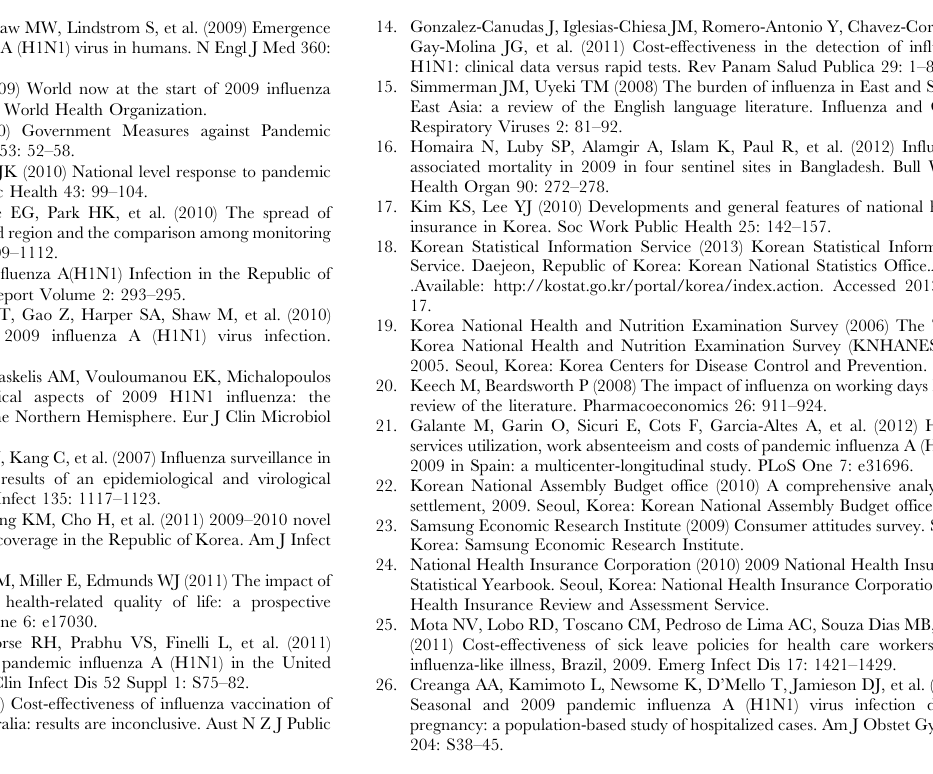
Table S1 Annual Medical Costs for Pneumonia